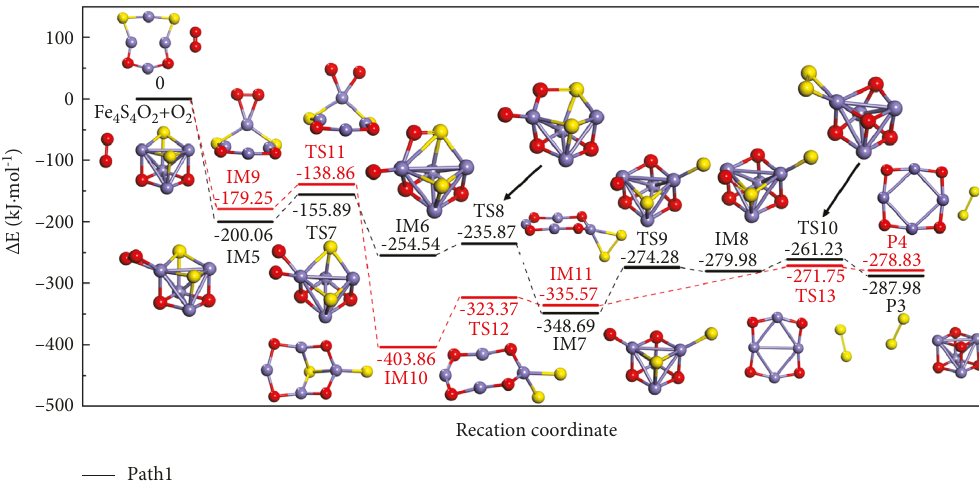
Figure 7: The stage 2 reaction path of Fe 4 S 4 clusters with O 2 on the nine-fold state potential energy surface.